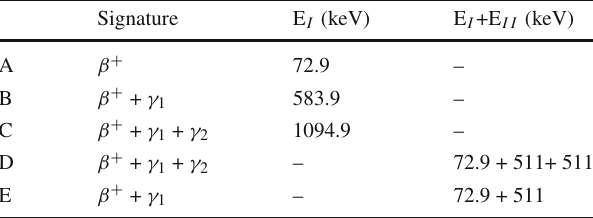
Table 1 Possible signatures of the 64 Zn electron capture - β + decay. In the column “Signature”, β + is the positron energy, while γ 1 and γ 2 are the two 511keV photons emitted by the positron annihilation. E I is the energy deposit in the scenario in which a single crystal is involved,